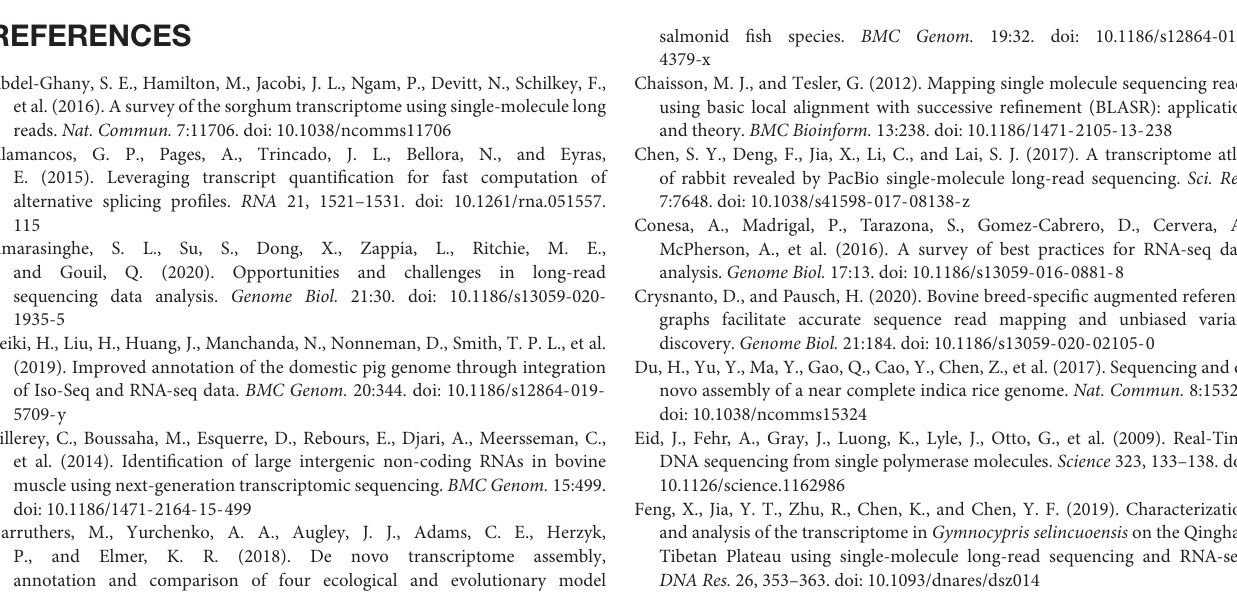
Supplementary Table 1 | Prediction of novel isoforms from known genes. Supplementary Table 2 | Prediction of the novel genes. Supplementary Table 3 | Annotation of new genes based on seven databases. Supplementary Table 4 | Results of AS identification. Supplementary Table 5 | Results of poly(A) prediction. Supplementary Table 6 | Prediction of the transcription factors. Supplementary Table 7 | Prediction of the novel